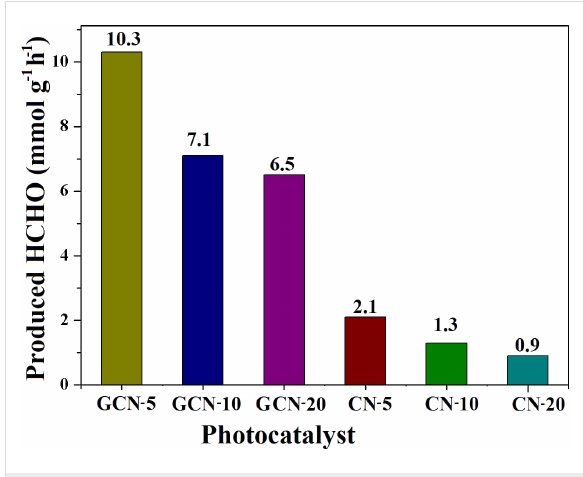
Figure 11: Apparent yield of HCHO in the presence of the various photocatalysts.